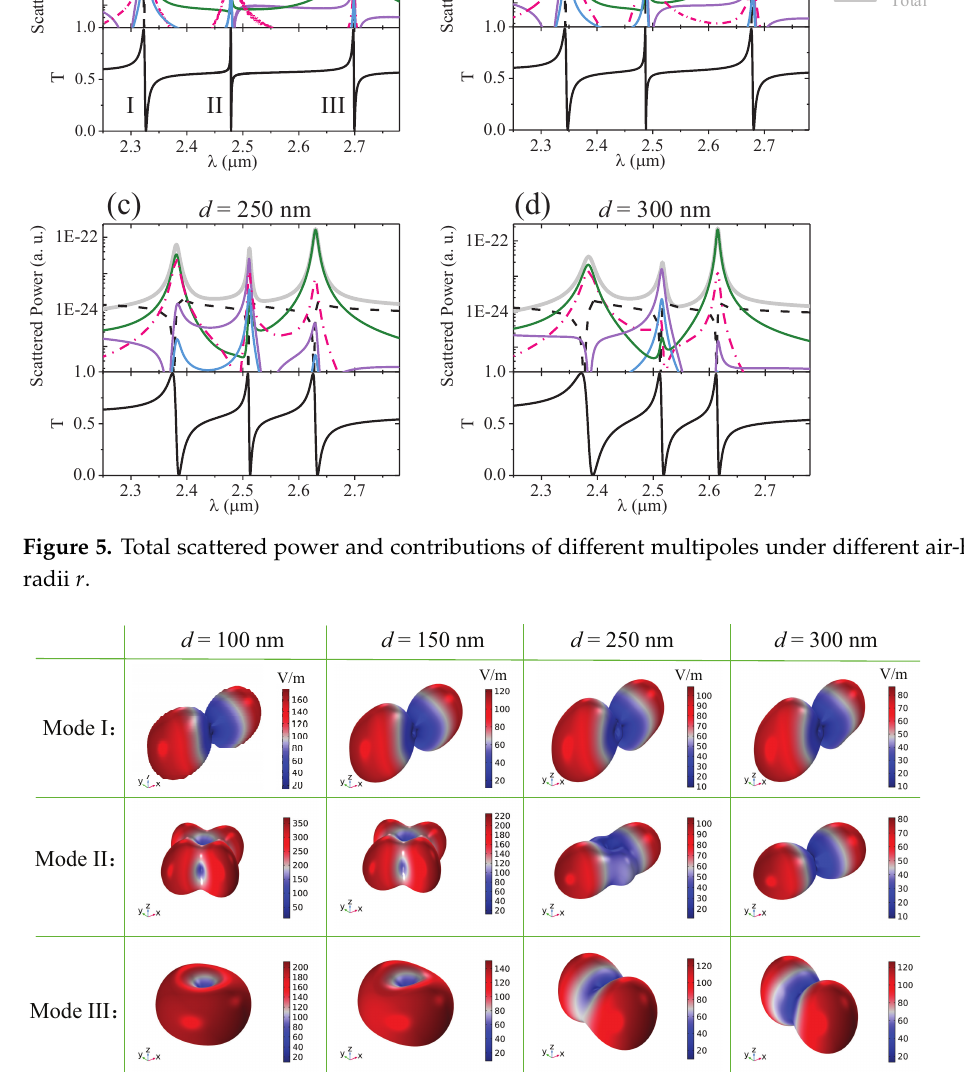
Figure 6. Radiation patterns of the unit cell at different asymmetric parameters d